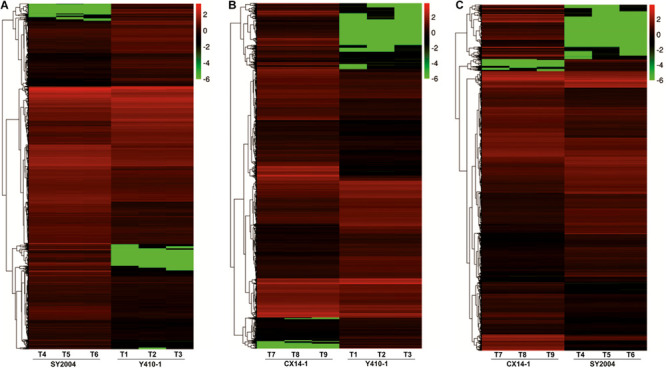
Heatmap representation of differentially expressed genes (DEGs) in the floral bud of early- and late-bolting Chinese cabbage double haploid lines. The expression patterns are based on the log2 of FPKM (fragments per kilobase of transcript per million fragments mapped for each gene) used for hierarchical clustering for each sample. The different columns represent different samples, with different rows representing different genes. Biological replicates: T1, T2, and T3 (Y410-1); T4, T5, and T6 (SY2004); and T7, T8, and T9 (CX14-1).